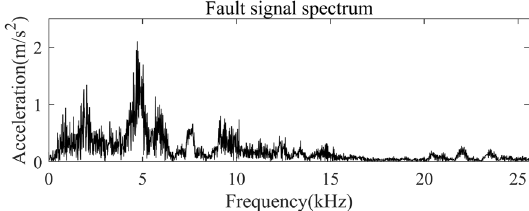
Figure 18 Fault signal spectrum